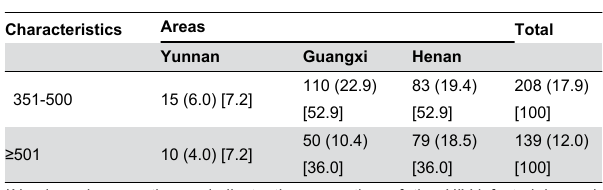
Table 2. Prevalence of HIV subtypes among